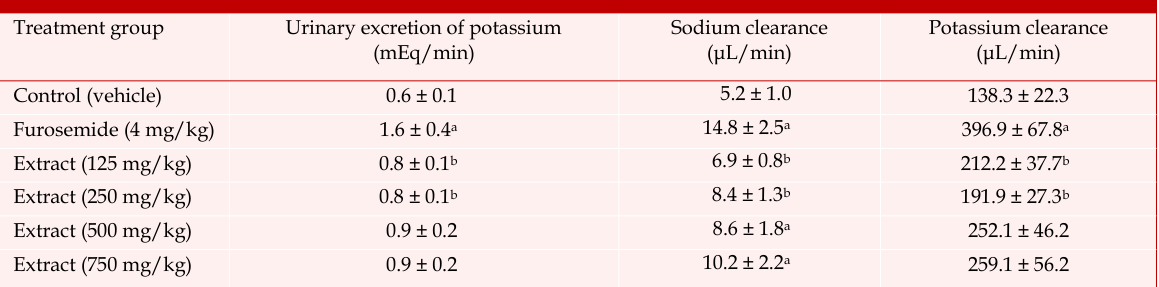
Effect of E. polystachya aqueous extract on urinary excretion and clearances of sodium and potassium